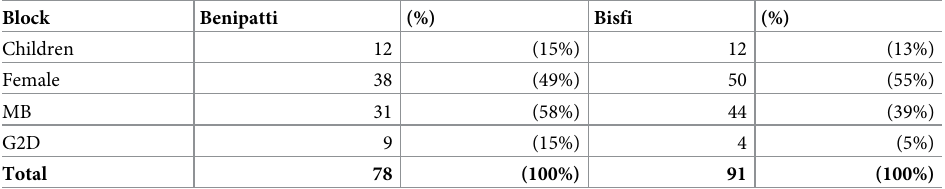
Table 1. Demographic characteristics of index cases enrolled.